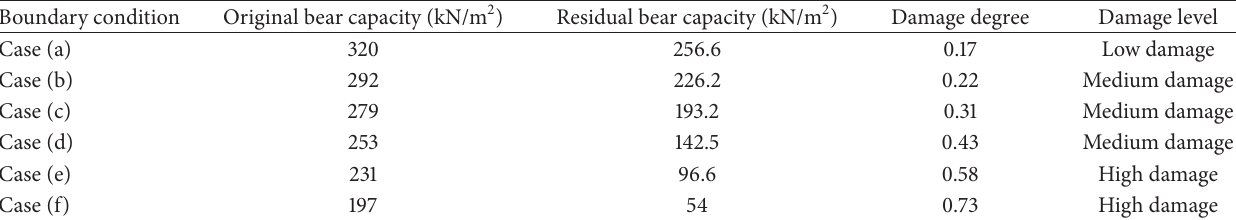
Table 3: Damage degree of RC slab under different boundary